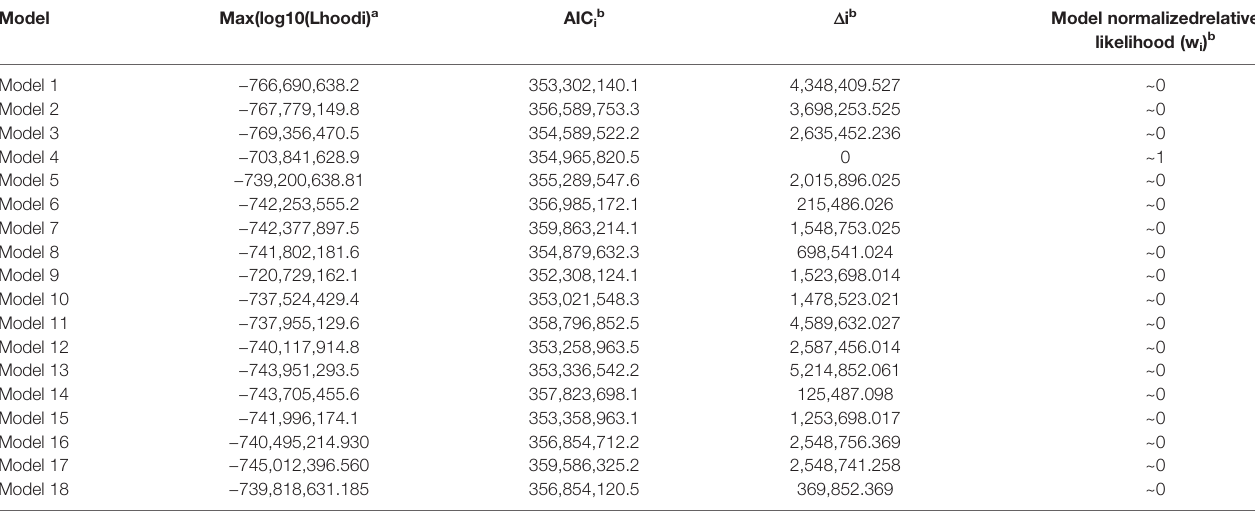
TABLE 1 | Relative likelihood of the different models. Model D i b Model normalizedrelative